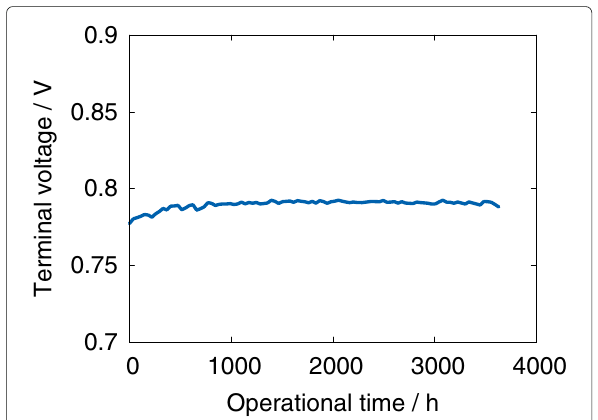
Fig. 7 Terminal voltage as a function of operational time during long-term